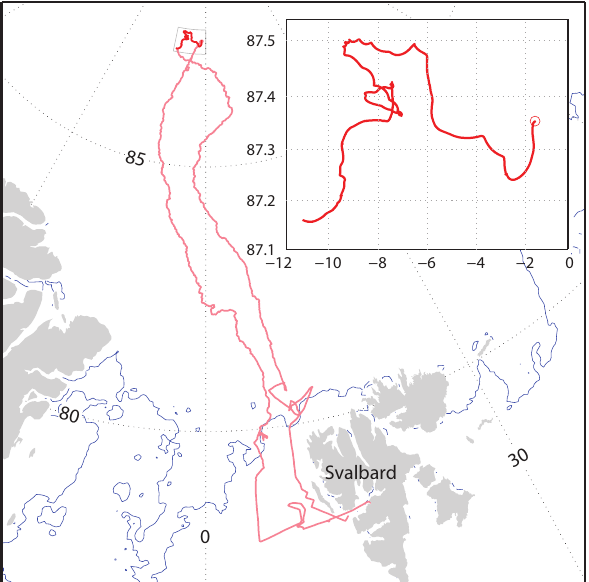
Fig. 2. The ship track from the ASCOS field campaign during 40 days from 2 August and to 8 September 2008. The insert shows the track of the ice drift for three weeks starting 12 August and ending 2 September.